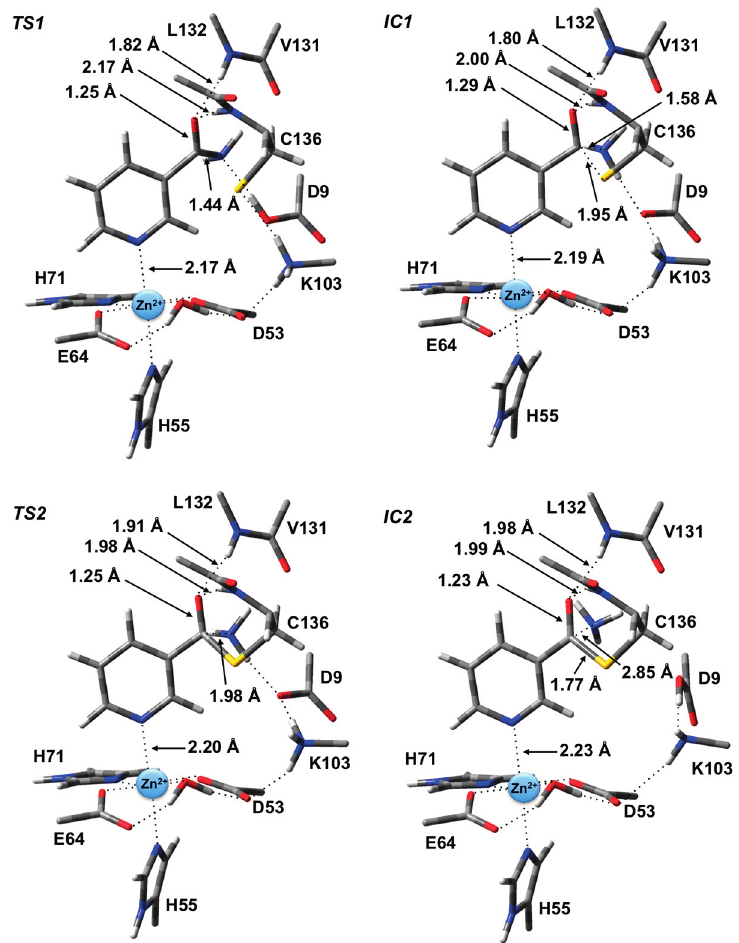
Figure 3. Optimized geometries obtained at the ONIOM(B3LYP/6-31G(d):AMBER96)-ME level of theory of the transition states ( TS1 and TS2 ) and intermediates ( IC1 and IC2 ) for the first stage of the overall mechanism of